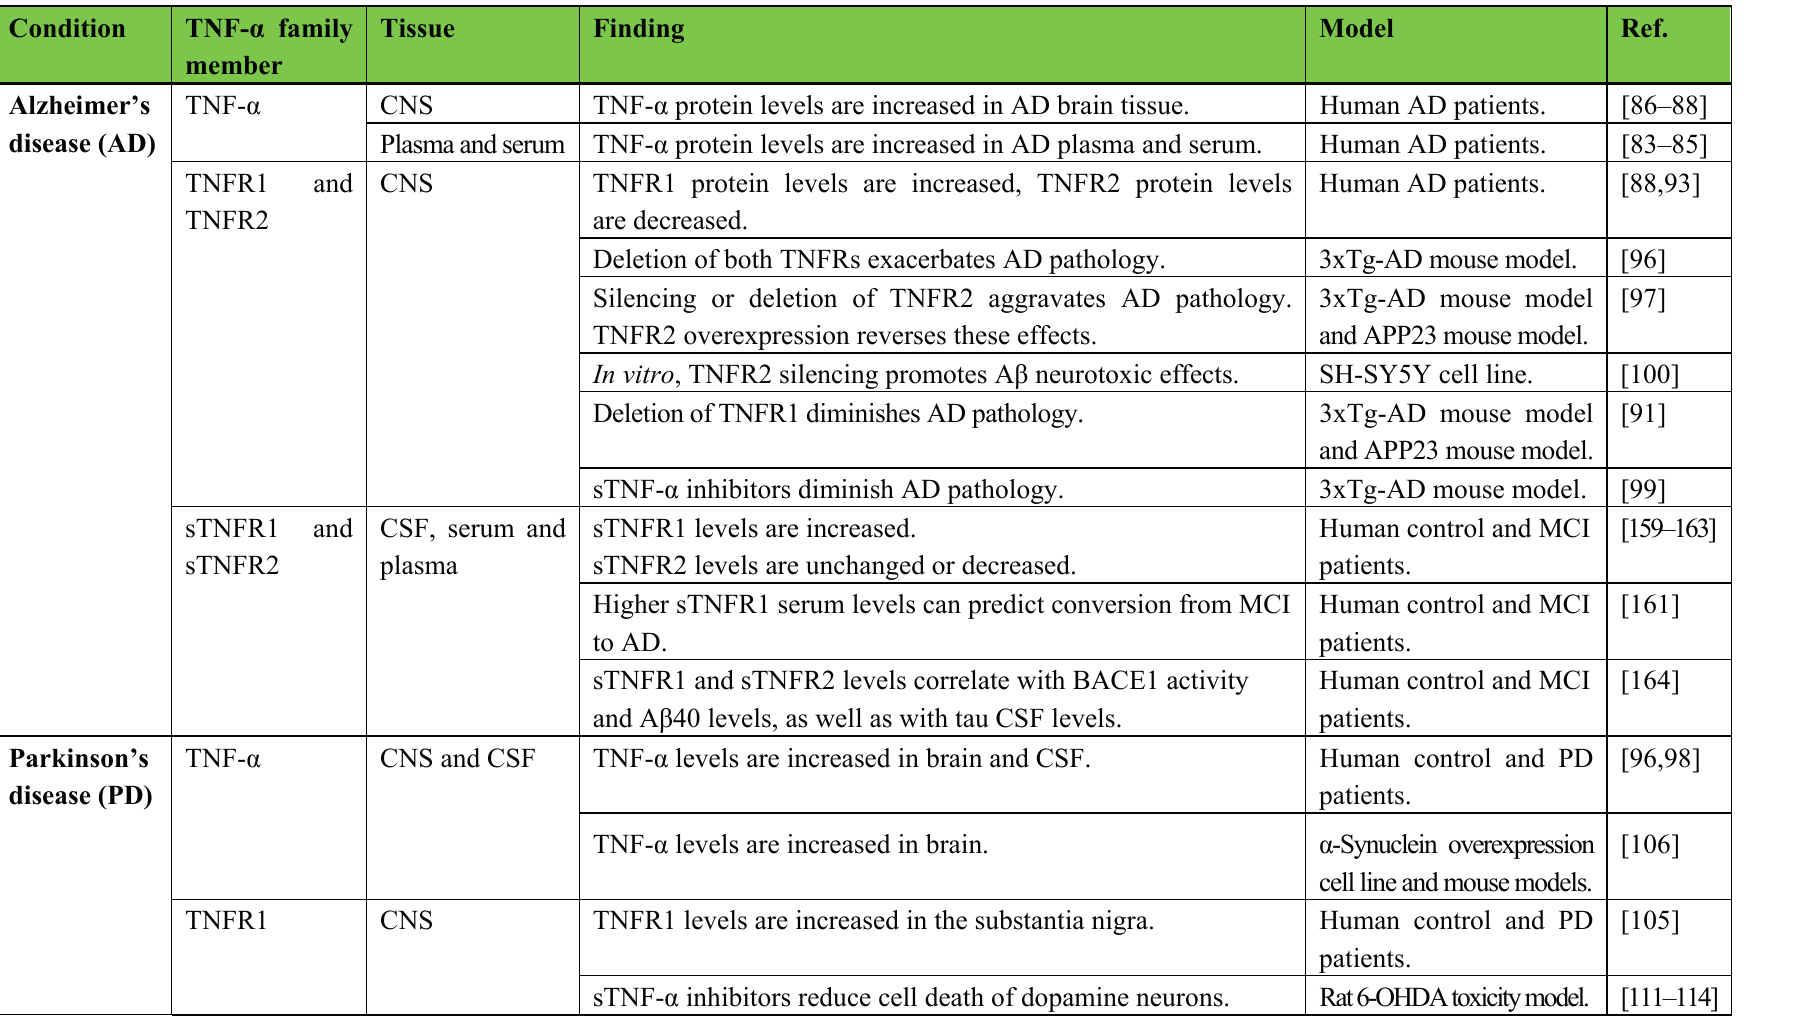
Table 1. Summary of the TNF- α family members that are subjects of this review, and their roles in neurodegenerative